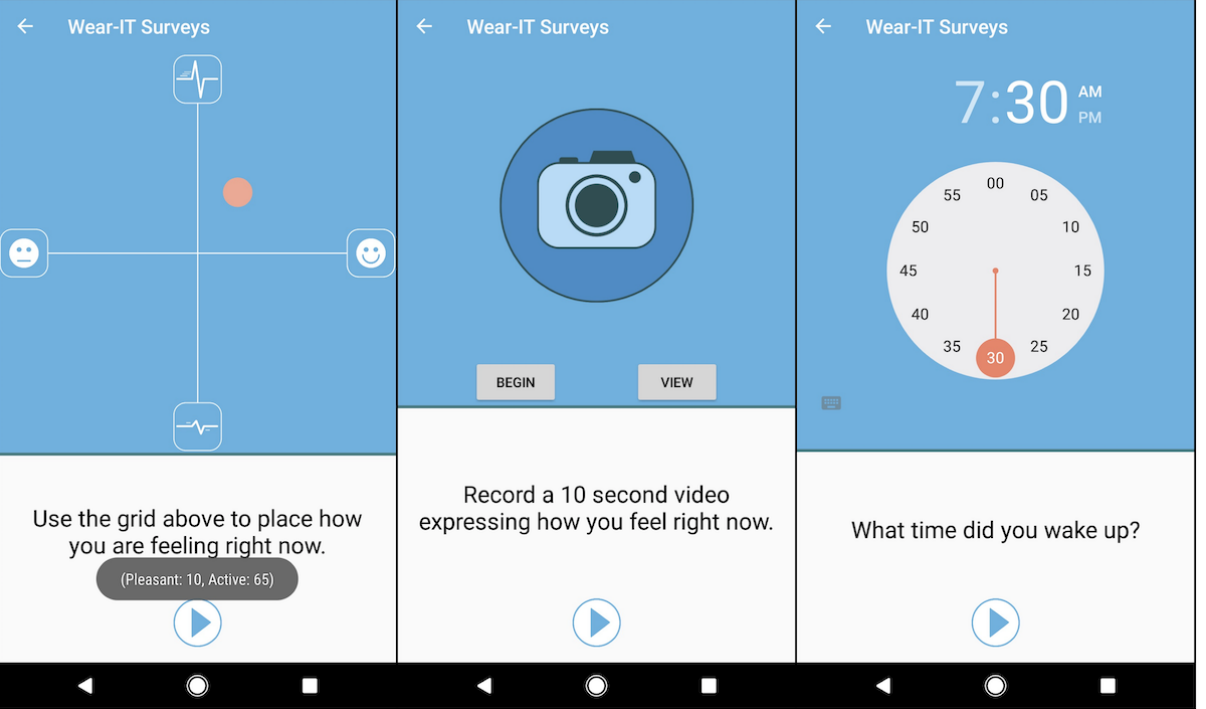
Figure 1. Three example questions from the Wear-IT framework. From left to right: core affect grid, affective video prompt, and time-picker.